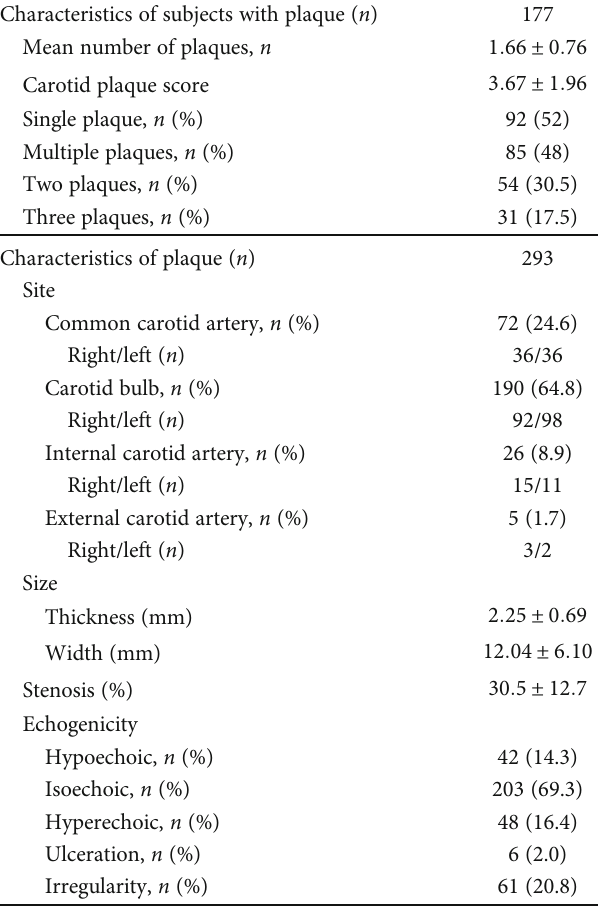
Table 2: Characteristics of subjects and carotid plaque. Characteristics of subjects with plaque ( n